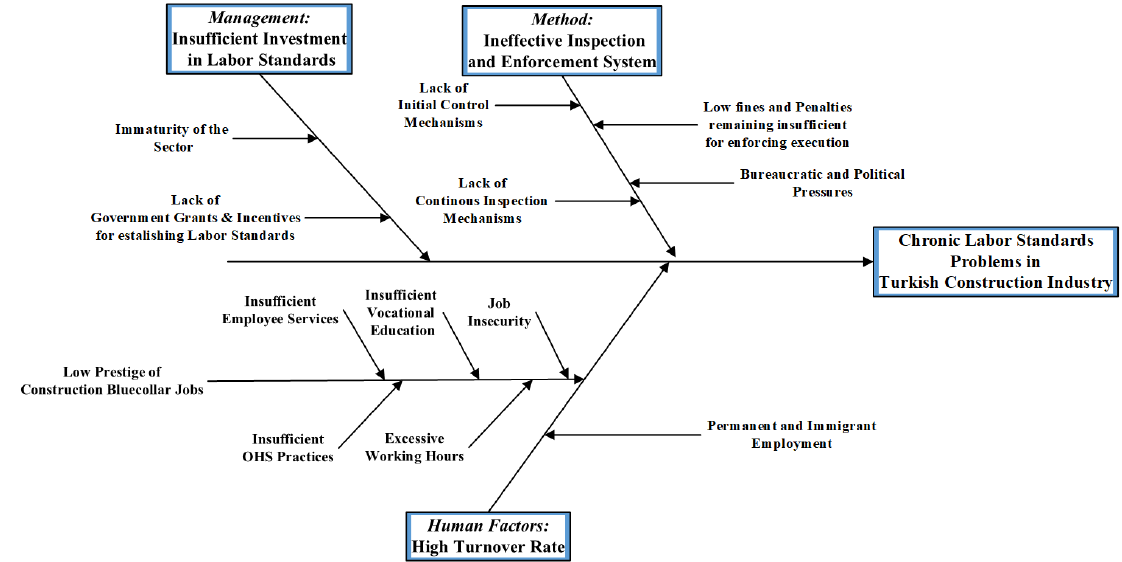
Figure 5. Cause-and-Effect Diagram.